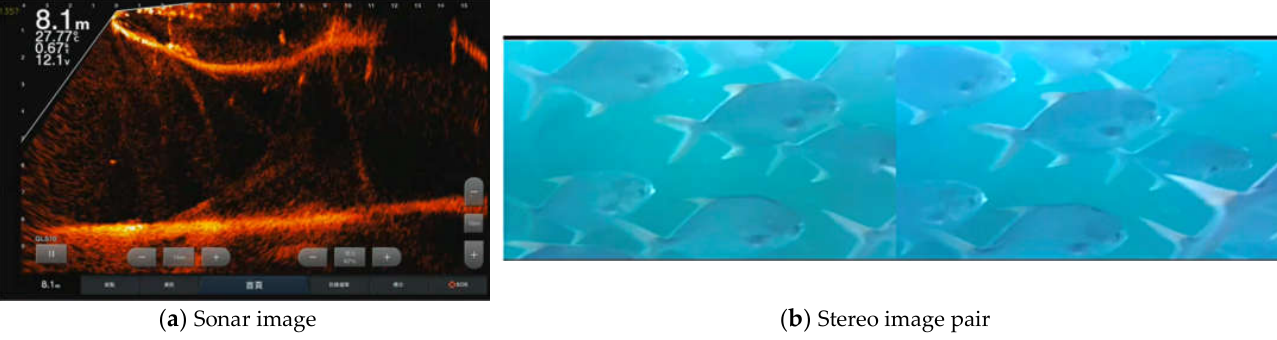
Figure 1. Data captured from the sensor devices is transmitted to the cloud for storage and big data analytics.